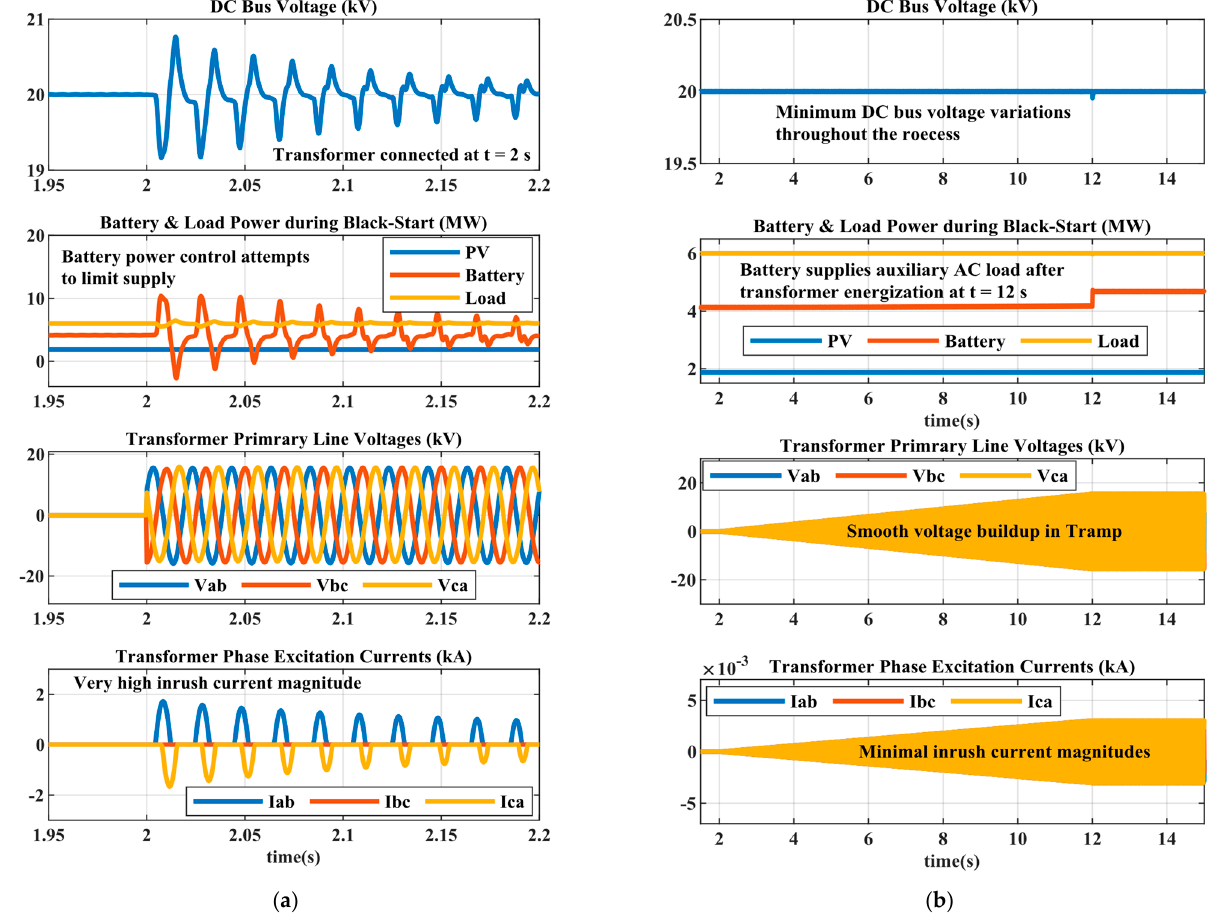
Figure 9. Simulation results for the EMS black ‐ start sequence (AC Side): ( a ): hard transformer energization, ( b ): soft transformer energization (voltage ramping).